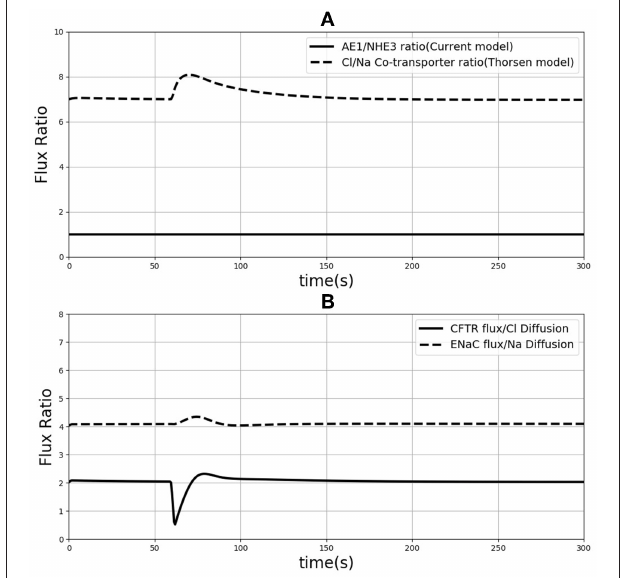
FIGURE 9 | (A) Ratio of sodium flux and Chloride flux through NHE3 and AE1 compare to NaCl co-transporter flux in the Thorsen model. (B) Chloride flux through CFTR and chloride diffusion ratio compare to the ration of sodium flux through ENaC and sodium diffusion.